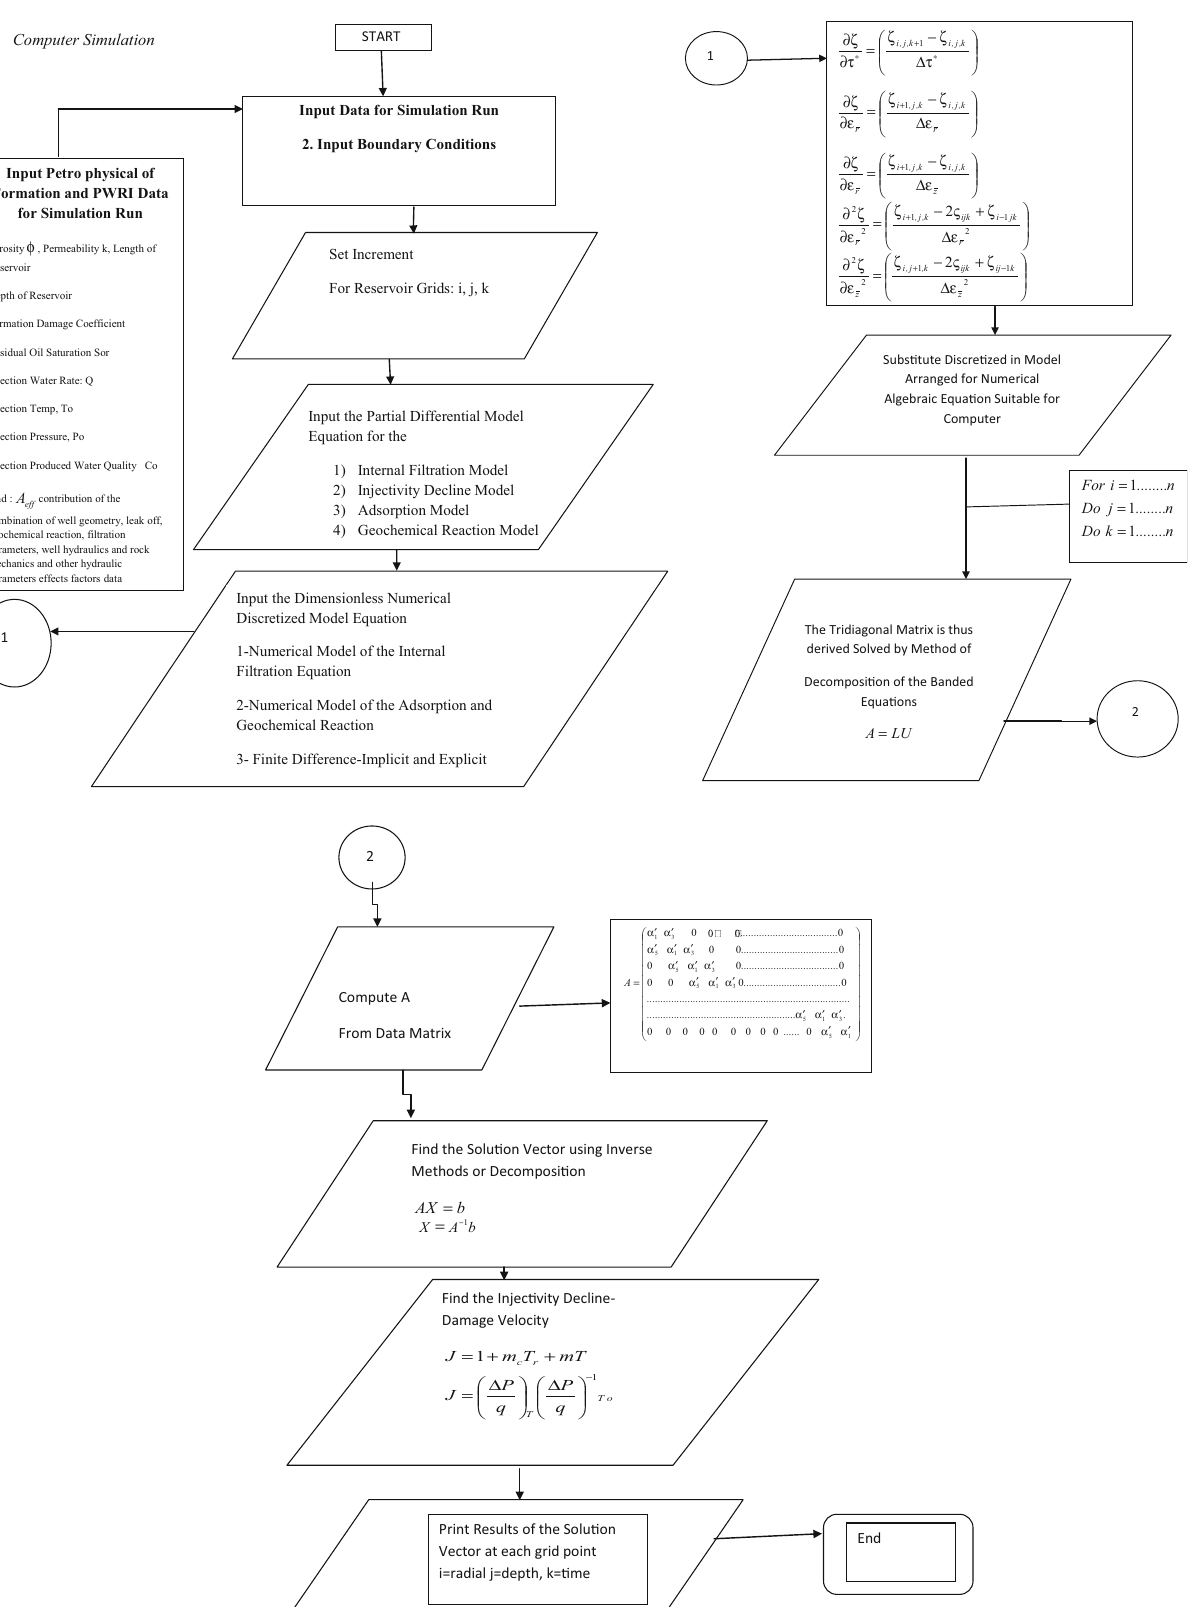
Fig. 4 Flow chart numerical simulation